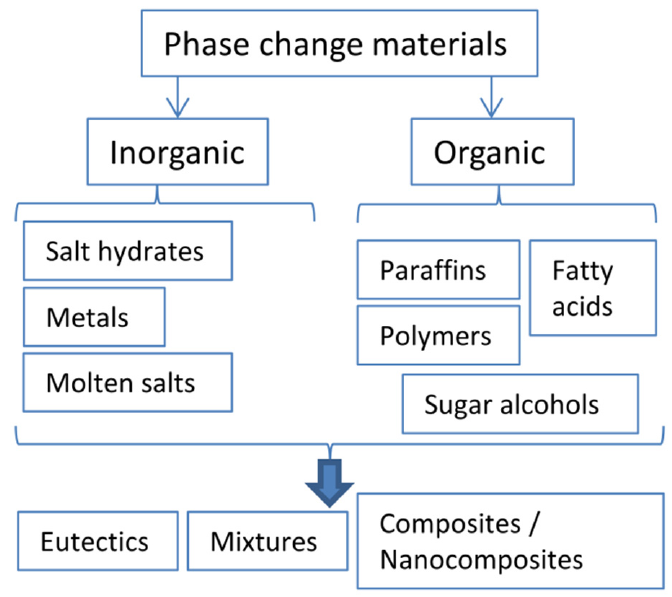
Figure 1. Classification of the main PCM classes.